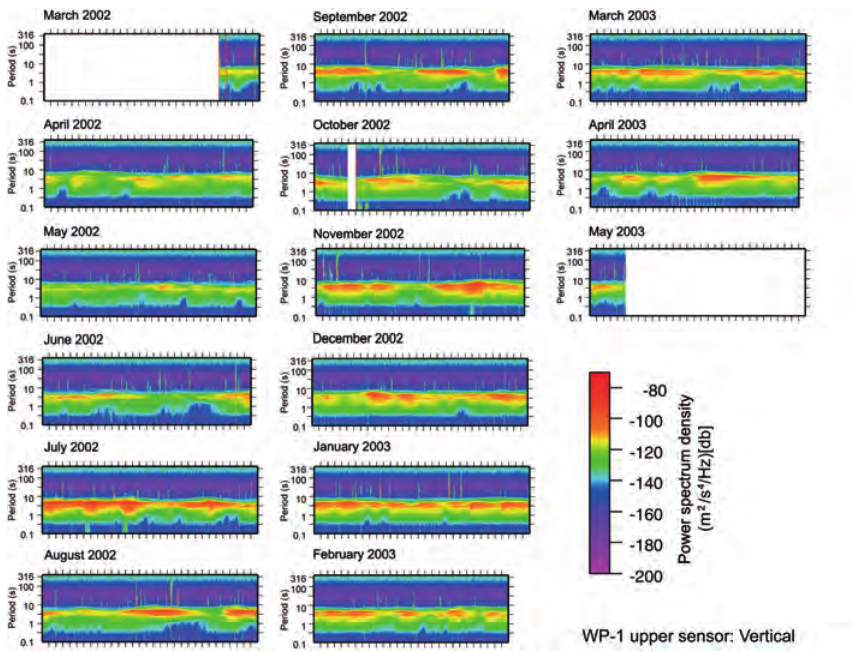
Fig. 7a. Running spectra of the records from the deep-sea borehole observatories. Each spectrum is calculated with a moving time window for a total of one hour record. Here the spectra are for the vertical component of the WP-1 Observatory. There is little change in noise levels above 10 s period. Many earthquakes are visible on the running spectra in periods greater than 10 s. Small temporal variations (maximum fluctuation is 10 dB) of noise levels for periods around a few seconds are